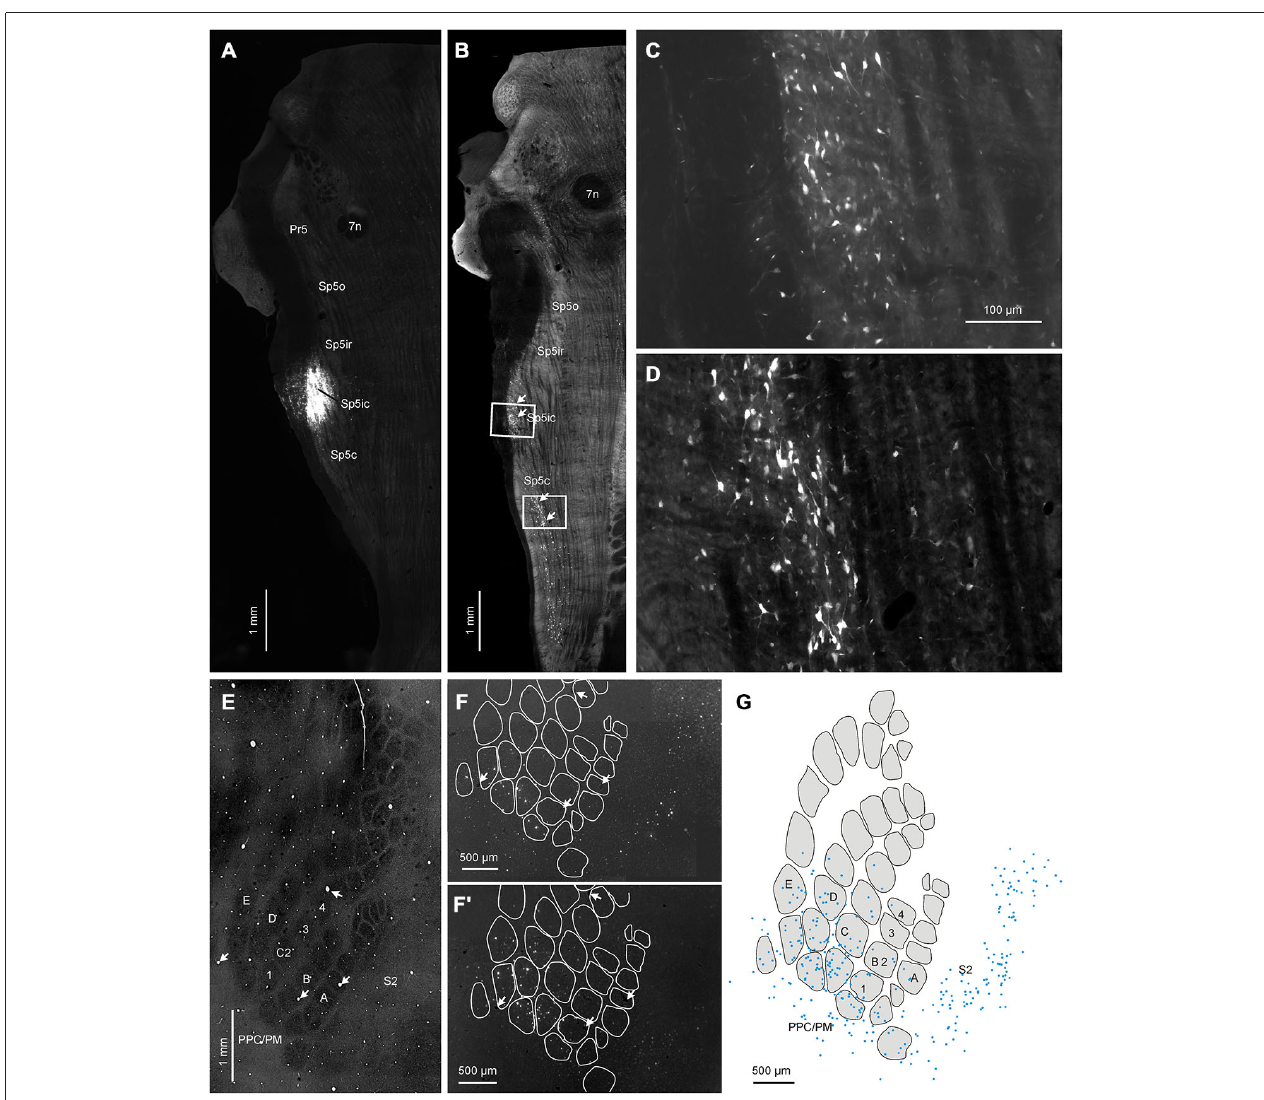
FIGURE 6 | Representative example showing cortical labeling patterns following a retrograde tracer (fluorogold, FG) deposit into the Sp5ic nucleus. (A) Horizontal section through brainstem showing location of the FG injection site. (B) Adjacent horizontal section showing the presence of clusters of retrogradely labeled cells (arrows) located in Sp5ic and Sp5c. White boxes denote insets shown at greater magnification in panels (C–D) . (E) Horizontal section through layer IV of the contralateral S1 cortex visualized for CO staining showing the spatial extents of the S1 barrel field, S2 and PPM/PC. (F,F (cid:48) ) . Two horizontal sections through infragranular layers, processed for visualization of the tracer, showing retrogradely labeled cells in S1, S2 and PPC/PM. (G) Digital reconstructions of the positions of the retrogradely labeled cells shown superimposed upon outlines of layer IV barrels and inter-barrel septa obtained from the CO-stained section. The sections containing the CO stained barrel field and the retrogradely labeled cells were aligned using blood vessels running orthogonal to the cortical surface (panels (E,F,F (cid:48) ) arrows) as control